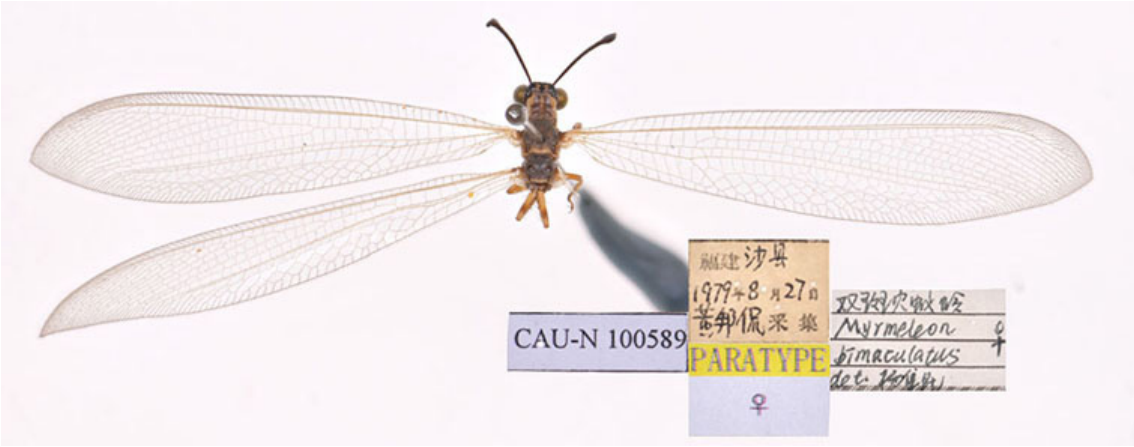
Fig. 11. Paratype of Myrmeleon bimaculatus Yang, 1999, ♀ (CAU-N 100589), dorsal